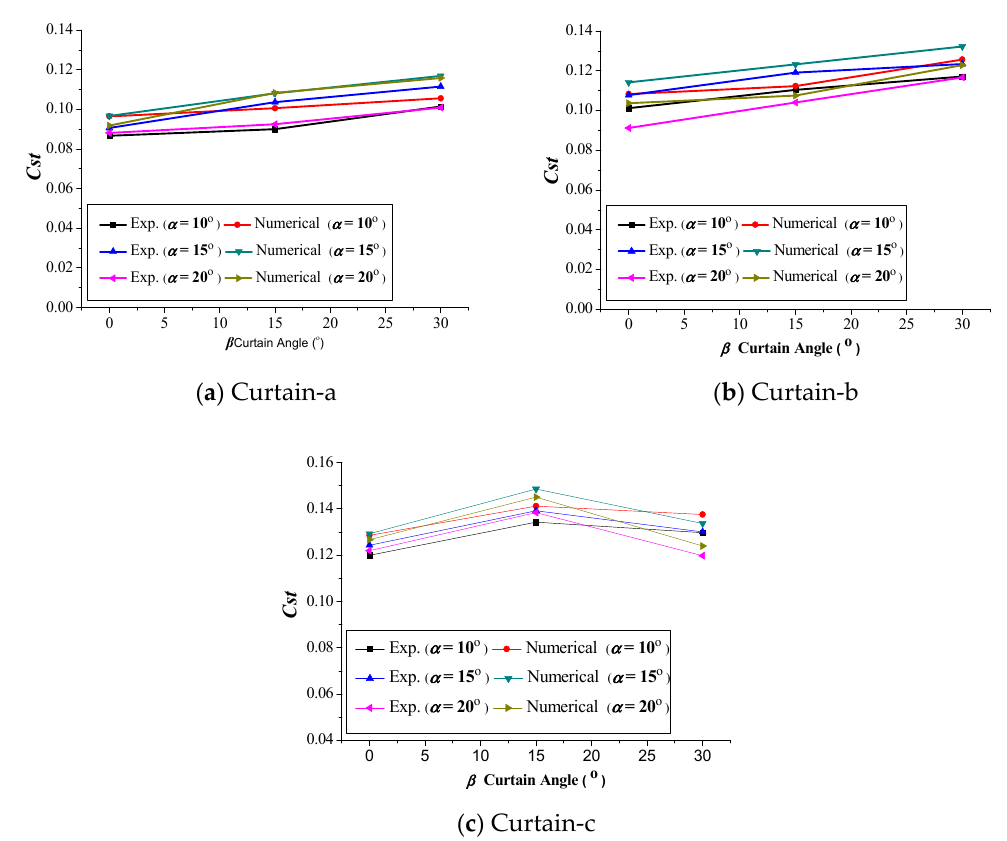
Figure 14. Static torque coefficients of ( a ) Curtain-a, ( b ) Curtain-b and ( c ) Curtain-c ( θ =